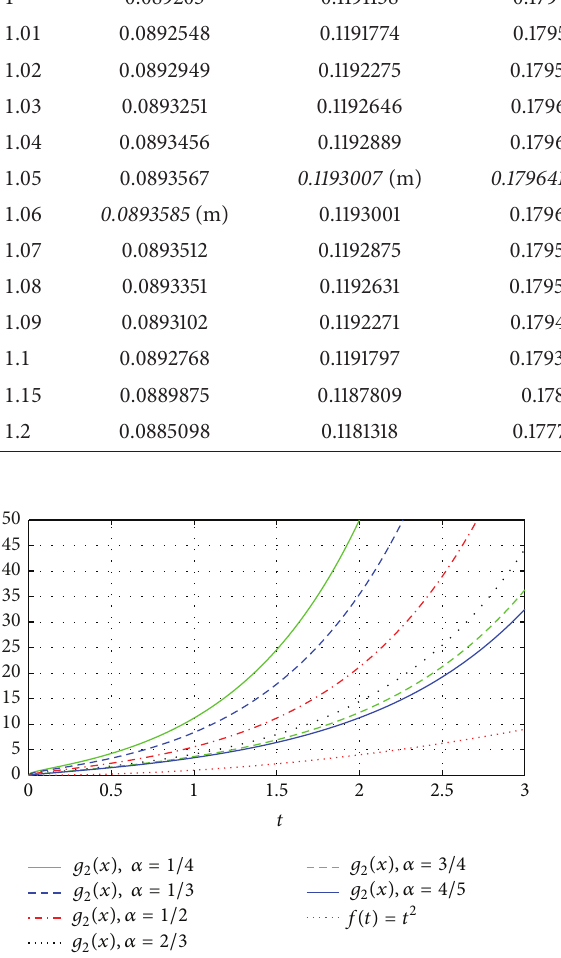
Figure 2: Curves of function 𝑔 2 (𝑡) and 𝑔 3 (𝑡)